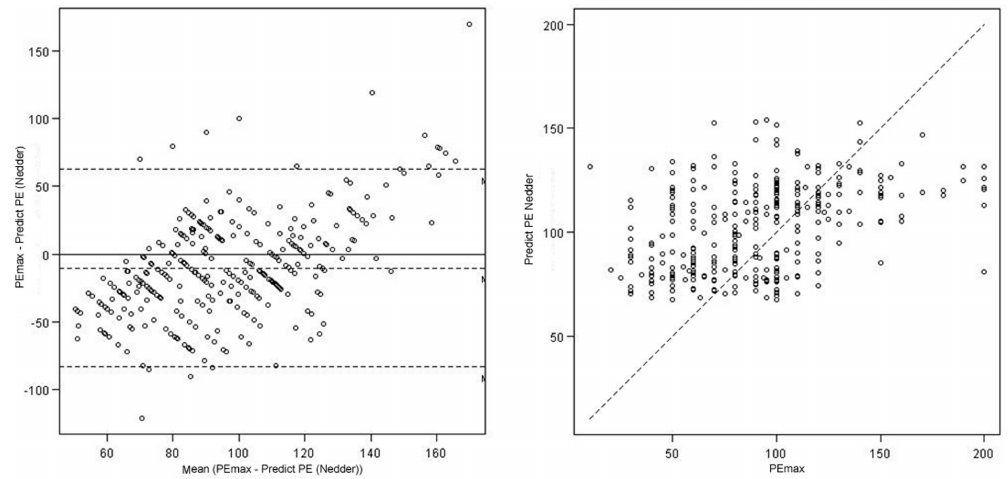
Fig. 5 - Bland-Altman plot and Lin's concordance coefficient of maximal expiratory pressure (MEP) values predicted by the formula of Neder et al. Confidence interval 95% (0.24 – 0.39); Lin coefficient (0.32)